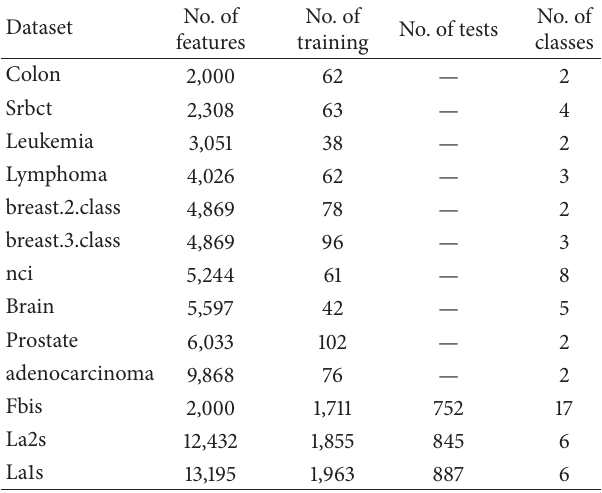
Table1:Descriptionofthereal-worlddatasetssortedbythenumber of features and grouped into two groups, microarray data and real- world datasets,